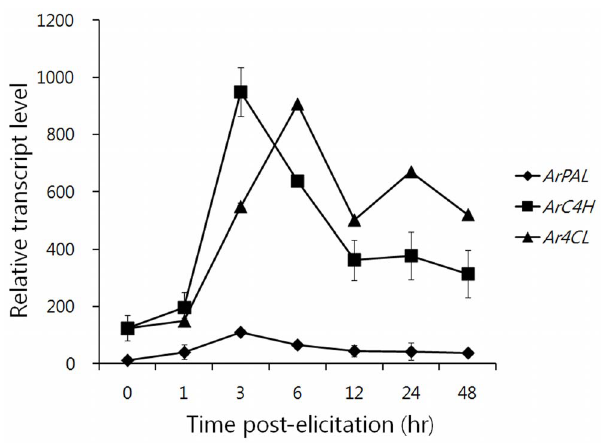
Figure 4. Time course of induction of phenylpropanoid biosynthetic genes by application of MeJA at 50 m M in the suspension cell culture of A.rugosa . The longitudinal axis indicates the expression levels of genes relative to that of actin . Each value is the mean of three replicates, and error bars indicate SDs.